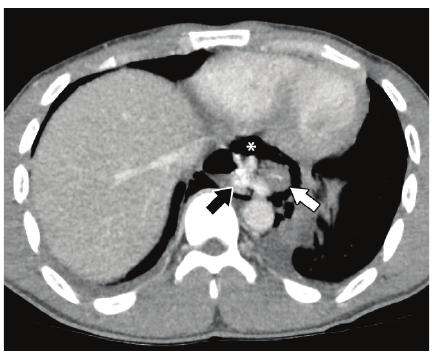
Figure 2: Chest computed tomography (CT) scan revealing a distal esophageal rupture with an oral contrast leak (indicated by the black arrow) from the ruptured esophagus (indicated by the white arrow), in addition to pneumomediastinum (asterisk) and left-sided pleural